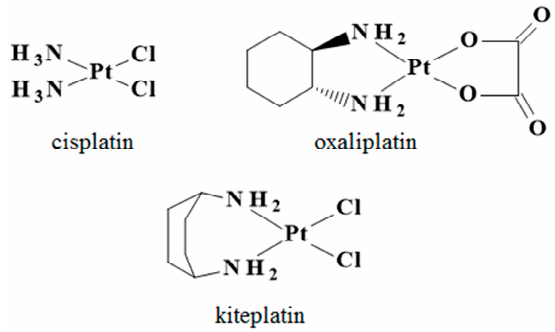
Figure 1. The three platinum-based anticancer compounds investigated in this work.